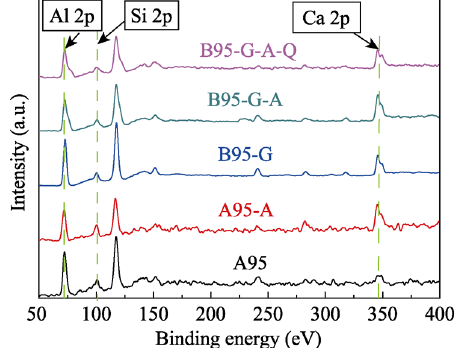
Fig. 5 XPS spectra of the 95% alumina ceramics before and after annealing and quenching.